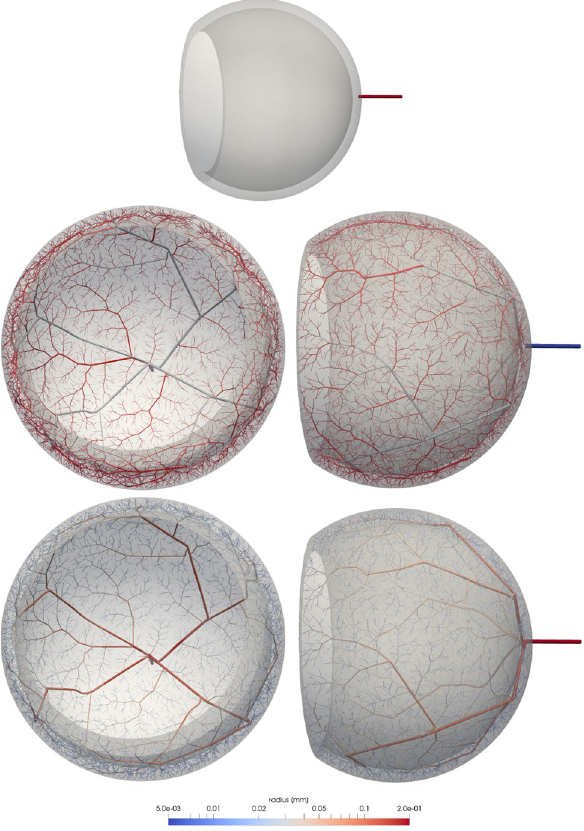
Figure 6. Inner retinal vasculature generated by a two-staged growth process: (first row) initialisation T 0 ; (second row) generated tree discriminating vessels given as initial conditions (blue), generated at the stage S 1 (light blue) and stage S 2 (red); (third row) variation of vessel radii along the generated network. Images generated with ParaView version 5.4 available at https ://www.parav